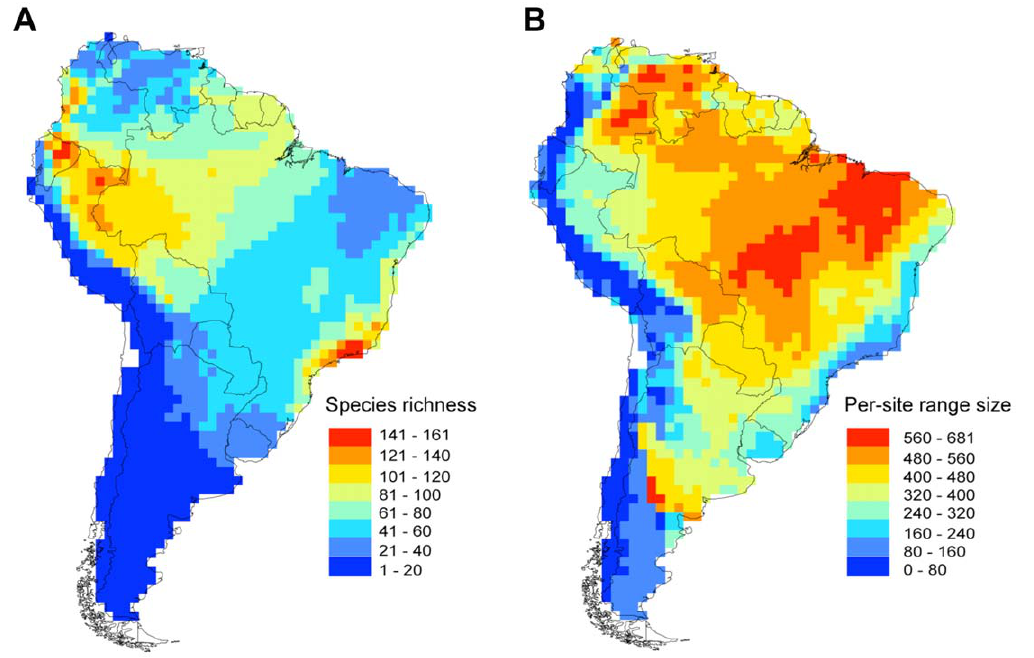
Figure 1. Geographic patterns of anuran biodiversity in South America. Maps depicting (A) species richness and (B) per-cell range size.